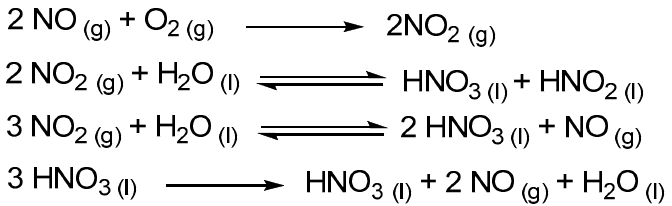
Figure 7. Common NO and NO 2 reactions in water/O 2 proposed in a previous report [69]. To date, nitric acid has been removed by evaporation by heating under reduced pressure.